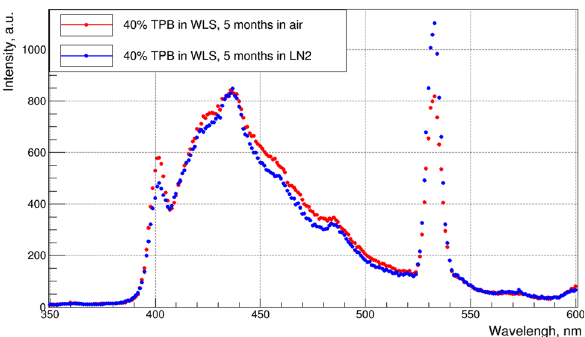
Fig. 3 Fluorescence spectra of the coated nylon samples stored in liq- uid nitrogen for 5 months (blue) and in air (red). The intensity scale is not comparable to that of Fig. 2. Since a lattice is used as an analyser, a scattering peak at double wavelength of the excitation beam of 400 nm